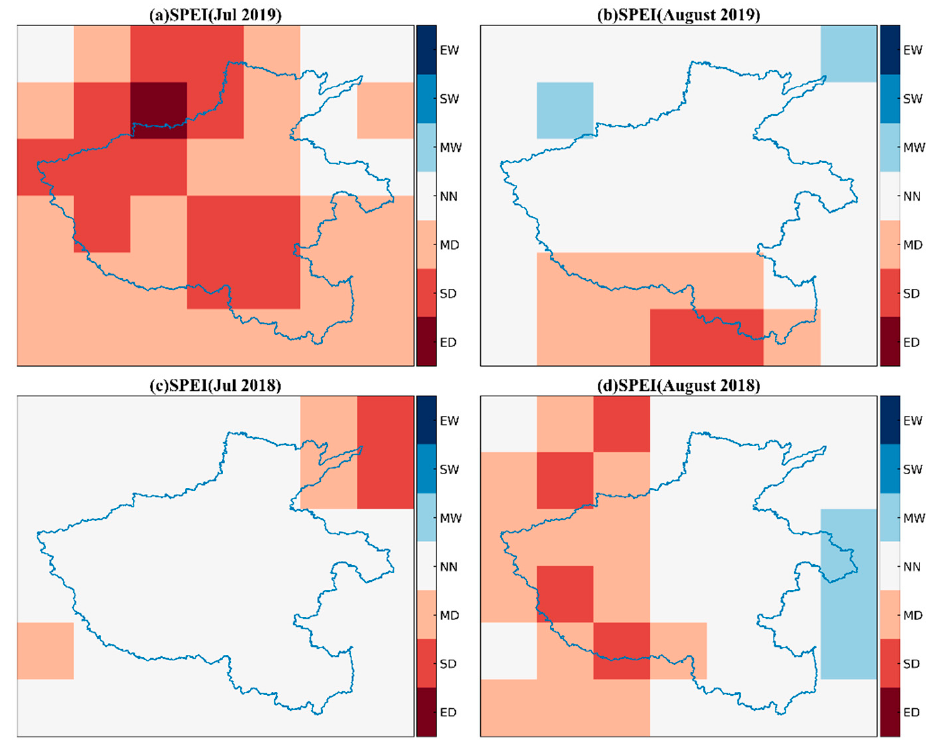
Figure 15. Spatial and temporal patterns of drought characterized by SPEI for July ( a , c ) and August ( b , d ) of 2018 and 2019. The abbreviations are as follows: EW, extremely wet; SW, severely wet; MW, moderately wet; NN, near normal; MD, moderately dry; SD, severely dry; ED, extremely dry.